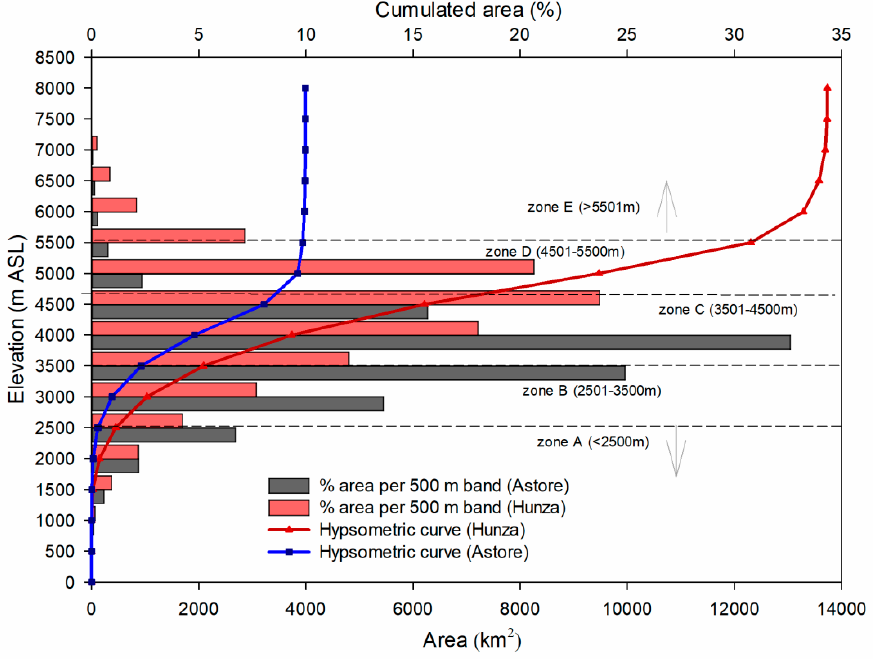
Figure 2. Hypsometric curve of Astore and Hunza estimated through the digital elevation model.